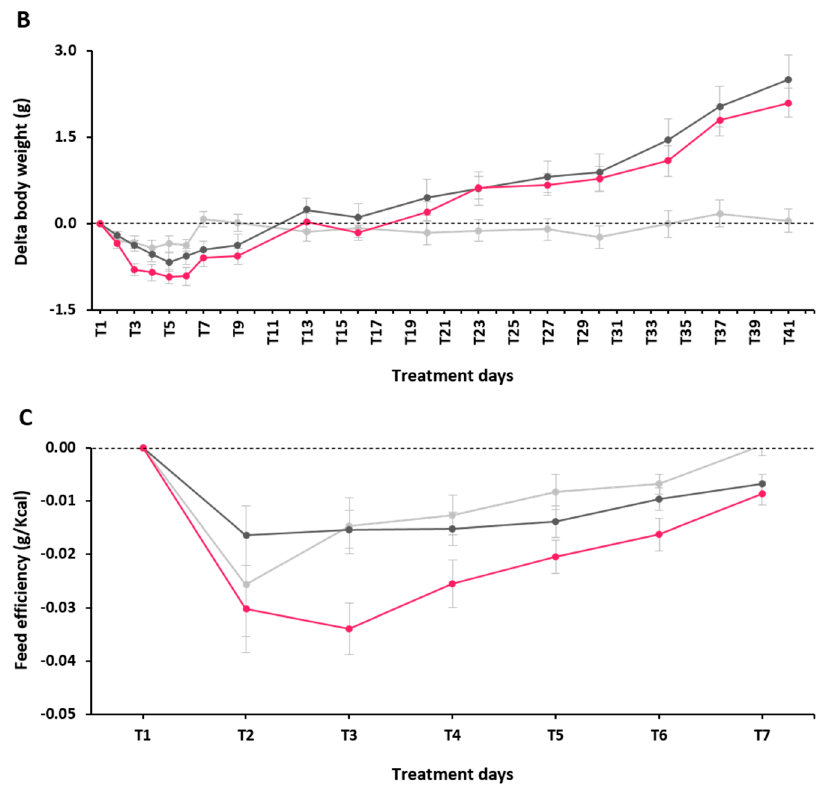
Figure 1. Effect of alpha-galacto-oligosaccharides ( α -GOS) on anthropometric parameters and food intake during the treatment phase. ( A ) Caloric intake. ( B ) Daily delta body weight. ( C ) Feed efficiency during the first week of treatment phase. Data are mean ± standard error of the mean (SEM). Normal chow (NC), light gray lines, n = 16; high-fat diet (HFD)-control, dark grey lines, n = 20; HFD- α -GOS, pink lines, n = 20. * p < 0.05 vs. HFD-control group; ** p < 0.001 vs. HFD-control group; only statistical comparisons between HFD groups are shown. Treatment days (T) refer to the number of days after initiation of treatment with either the vehicle (NC and HFD-control groups) or α -GOS (HFD- α -GOS group).